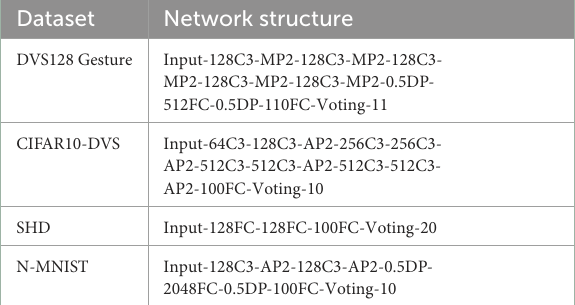
TABLE 3 Network structure.